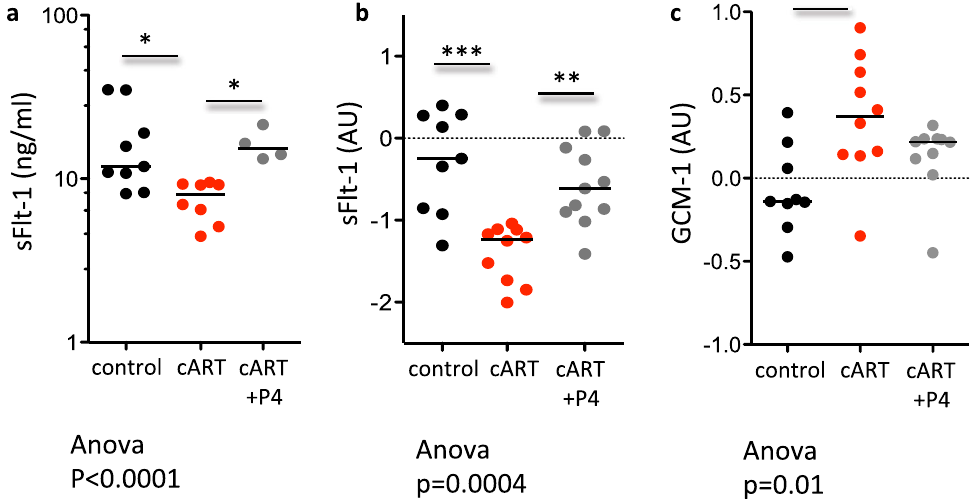
Figure 5. Progesterone supplementation prevents cART-associated dysregulation of sFlt-1 and Gcm-1. Pregnant mice were treated by gavage with cART (zidovudine/lamivudine/lopinavir/ritonavir) or water as a control starting on GD1 until sacrifice on GD15, and were supplemented subcutaneously with either progesterone (0.5 mg in 100 µ l of corn oil on GD1, 5, 9, and 13), or corn oil as a control. Peripheral sFlt-1 levels assessed by EIA ( a ), and placental expression levels (log transformed) for sFlt-1 ( b ) and Gcm-1 ( c ) assessed by qPCR are shown for mice treated with control (black), cART (red), or cART plus progesterone (P4) (grey). For ( a ) n = 9 dams for control, n = 8 dams for cART, and n = 4 dams for cART + P4. For ( b ) and ( c ) n = 9 placentas from 5 dams for control, n = 10 placentas from 5 dams for cART, and n = 11 placentas from 5 dams for cART + P4. Statistical comparisons by one way-ANOVA with Bonferroni post-test. * p < 0.05, ** p < 0.01, *** p <